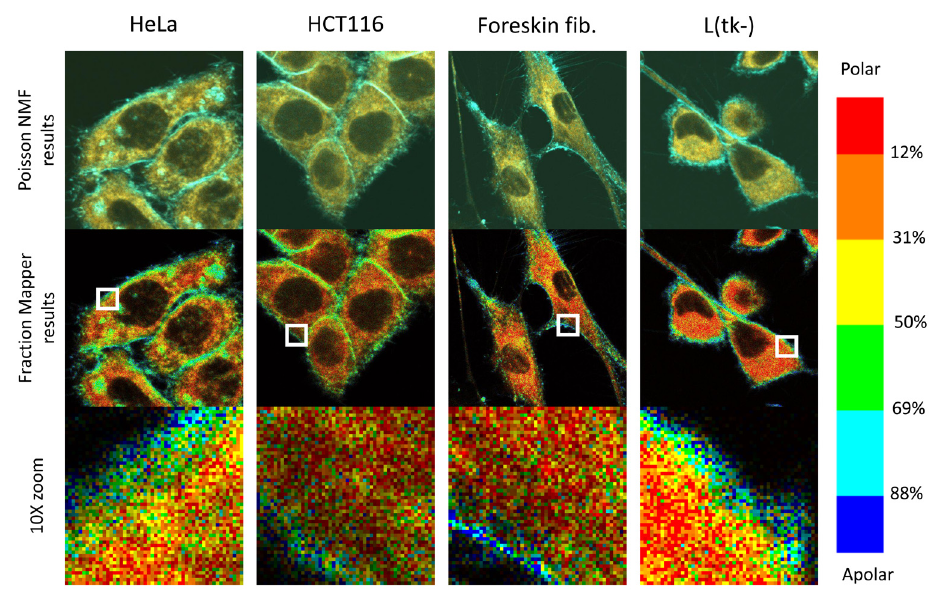
Figure 13. C-laurdan stains various cell types in similar patterns. Human HeLa cells (first column), HCT116 cells (second column), foreskin fibroblasts in primary culture (third column) and mouse L(tk-) cells (fourth column) were all grown on glass coverslips before staining with C-laurdan, imaging and analysing the images by the standard procedure, as described in Methods. Top row: overlay of the two channels obtained after spectral decomposition with PoissonNMF (cyan, apolar environment; orange, polar, water-exposed environment). Middle row: the two channel stacks were processed with the Fraction Mapper plugin using the six-colour 2,3,3,3,3,2 LUT shown on the right-hand side. Bottom row: 10x magnifications of the 52×52 pixel regions indicated by white squares in the middle row. Each pixel is 100×100 nm, and each picture, taken at zoom 4, covers 52×52